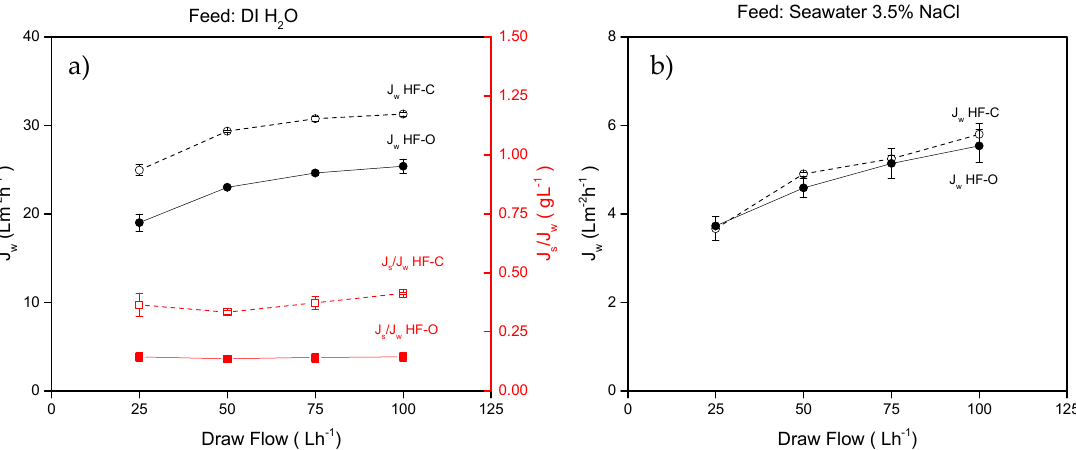
/ J w for HF–C and HF–O modules as a function of draw flow rate when DI Figure 7. a ) J w and J s /J w for HF–C and HF–O modules as a function of draw flow rate when DI water Figure 7. ( a ) J w and J s